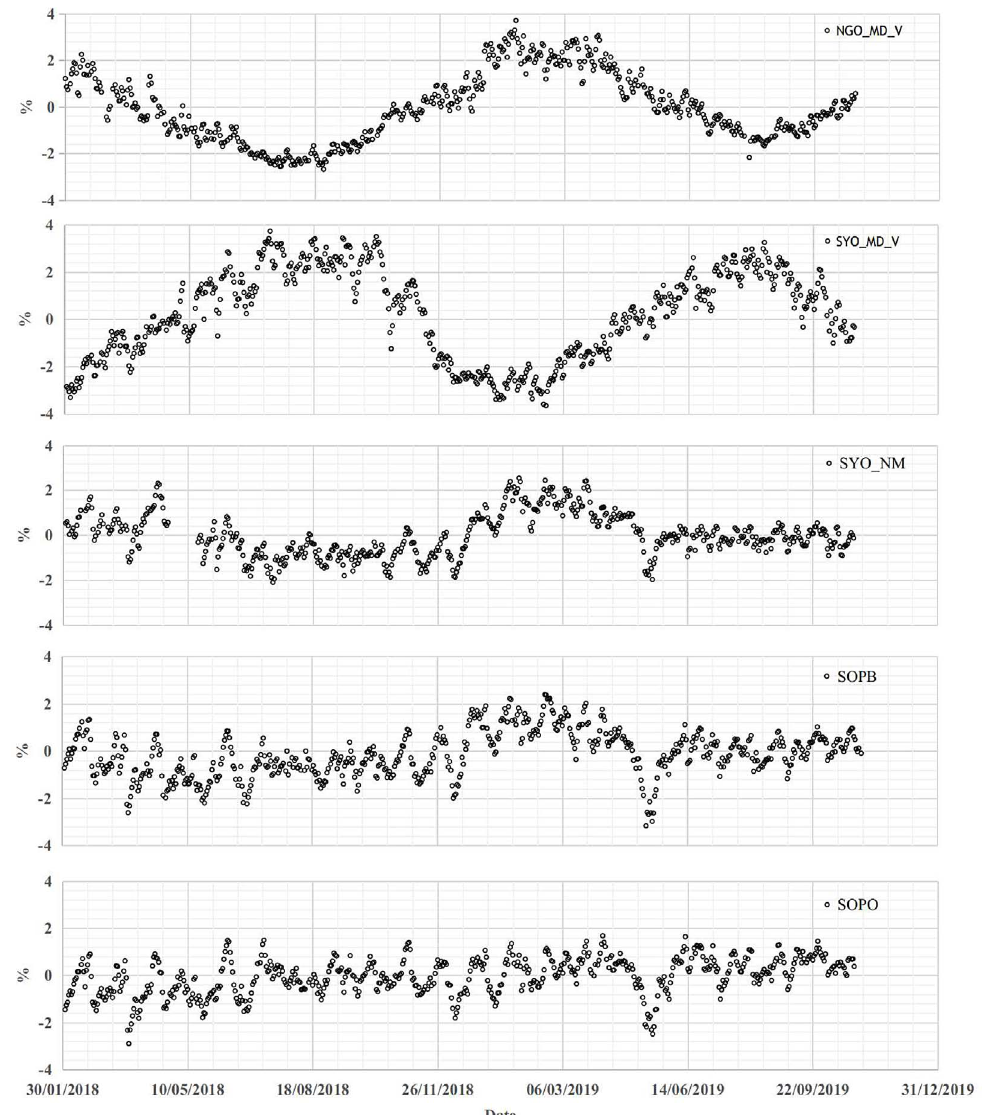
Fig. 7. Temporal variations of the pressure corrected daily mean count rates recorded by NMs and MDs. From top to bottom, each panel displays the percent deviation from the average of daily mean count rates in Nagoya MD vertical channel (NGY_MD_V), Syowa MD vertical channel (SYO_MD_V), Syowa NM (SYO_NM), Polar Bare NM (SOPB), and South Pole NM (SOPO), during a period between February, 2018 and October, 2019. Representative error of each data point is less than 0.1%. MD data in top two panels show clear seasonal variations due to the atmospheric temperature effect. Minor tick marks on the horizontal axis are indicated every 27